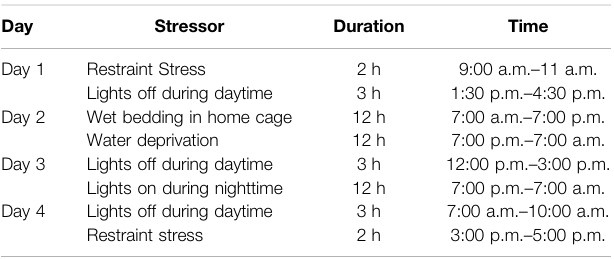
TABLE 1 | Schedule of STU stress paradigm. Stressors were applied pseudorandomly from day 108 – 111. Day